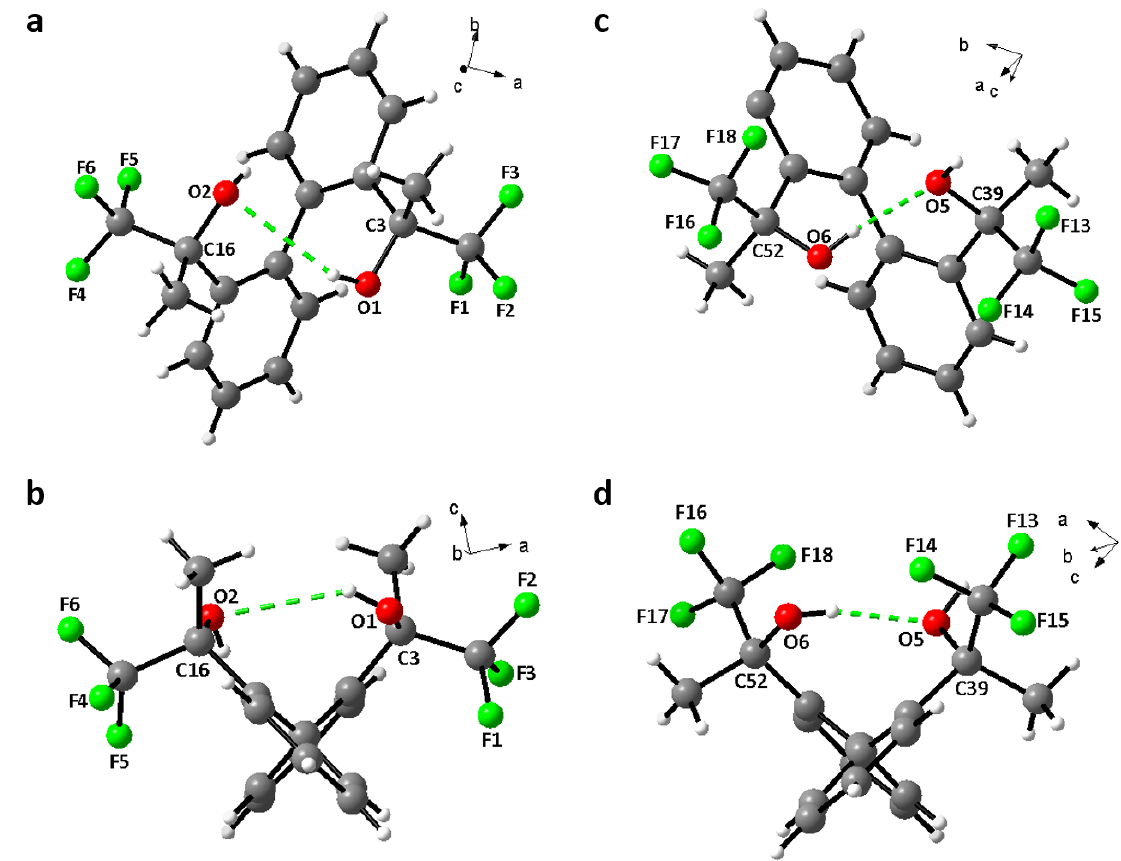
Figure 2. X-ray crystal structures of ( R , S a , R )-2 (a, b) and ( R , R a , R )-2 (c, d) at two different orientations to show (i) S a or R a atropselectivities; (ii) relative different spatial arrangements of the CF 3 - and CH 3 -substituents. Hydrogen bond interactions are highlighted as green dashed lines. Torsion angle of biphenyl rings for ( R , S a , R )-2 is 90.4° whereas for ( R , R a , R )-2 it is 85.3°.